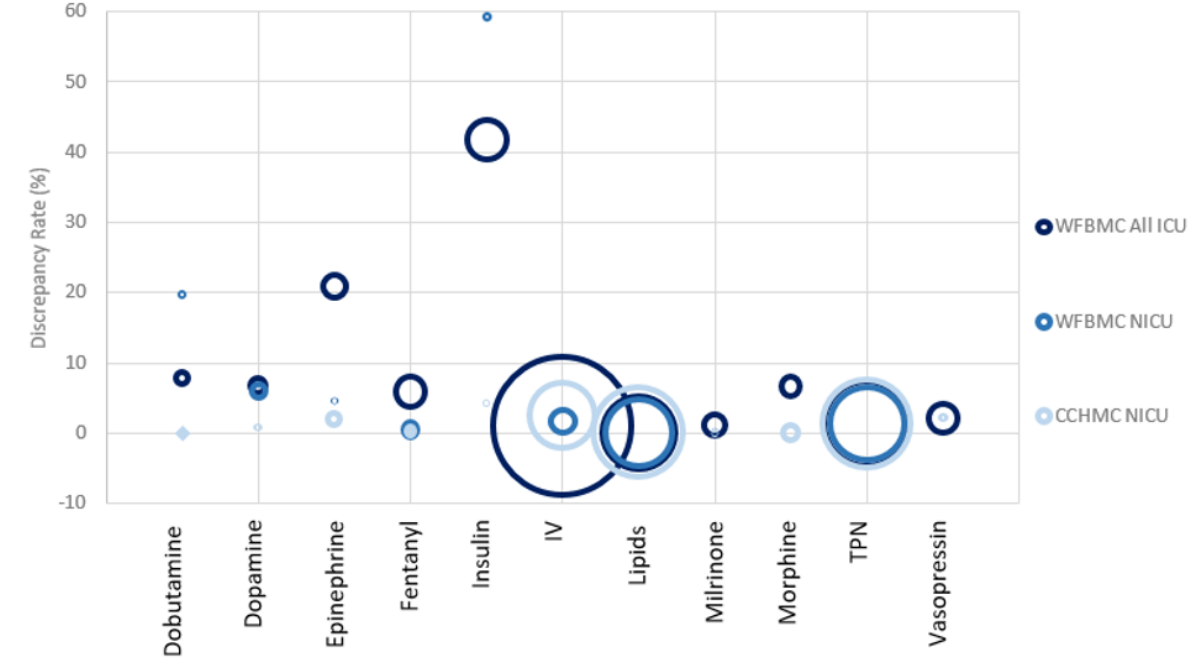
Figure 4. A comparison of discrepancy rates by medication and number of orders between (A) WFBMC All ICUs, (B) WFBMC NICU, and (C) CCHMC NICU. Circle radius correlates with the number of medication orders for the sites. CCHMC: Cincinnati Children’s Hospital Medical